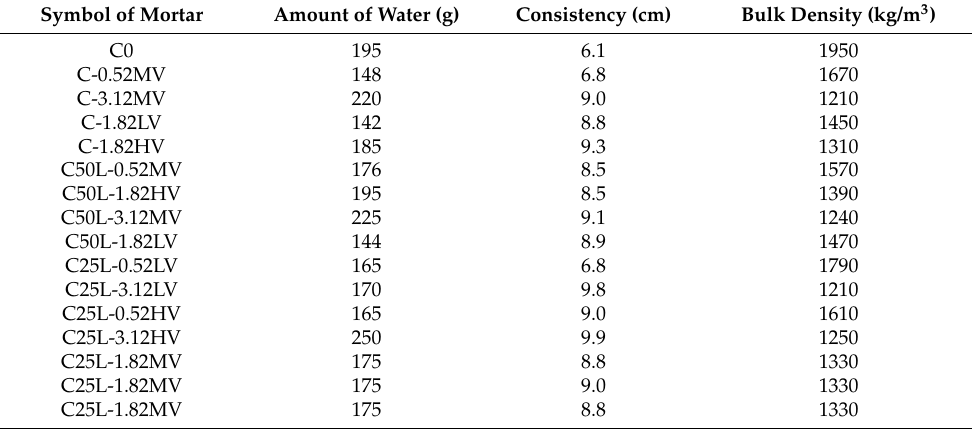
Table 6. Selected properties of fresh mortars.